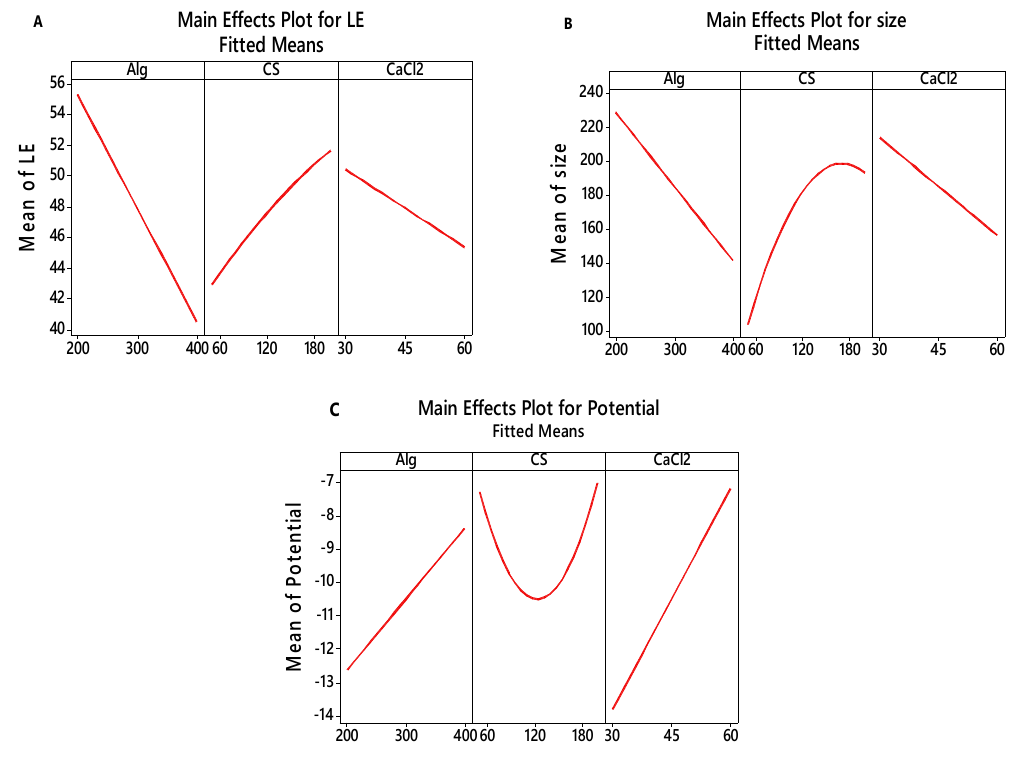
Figure 5. Main e ff ects plot for LE, particle size and zeta potential. Figure 5. Main effects plot for LE, particle size and zeta potential. 292